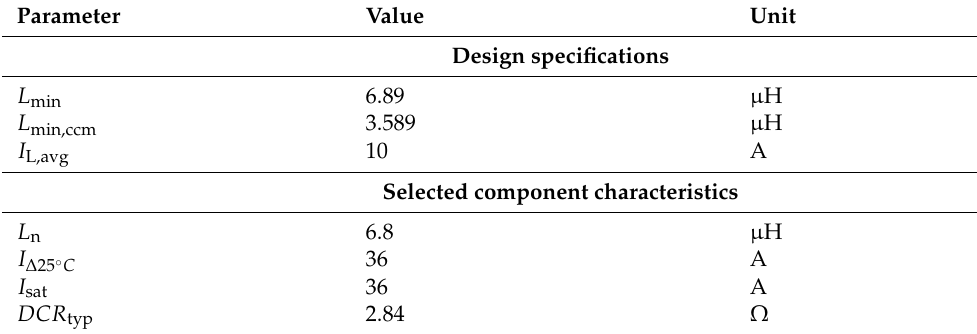
Table 2. Design specifications of the inductors and characteristics of the chosen [43].